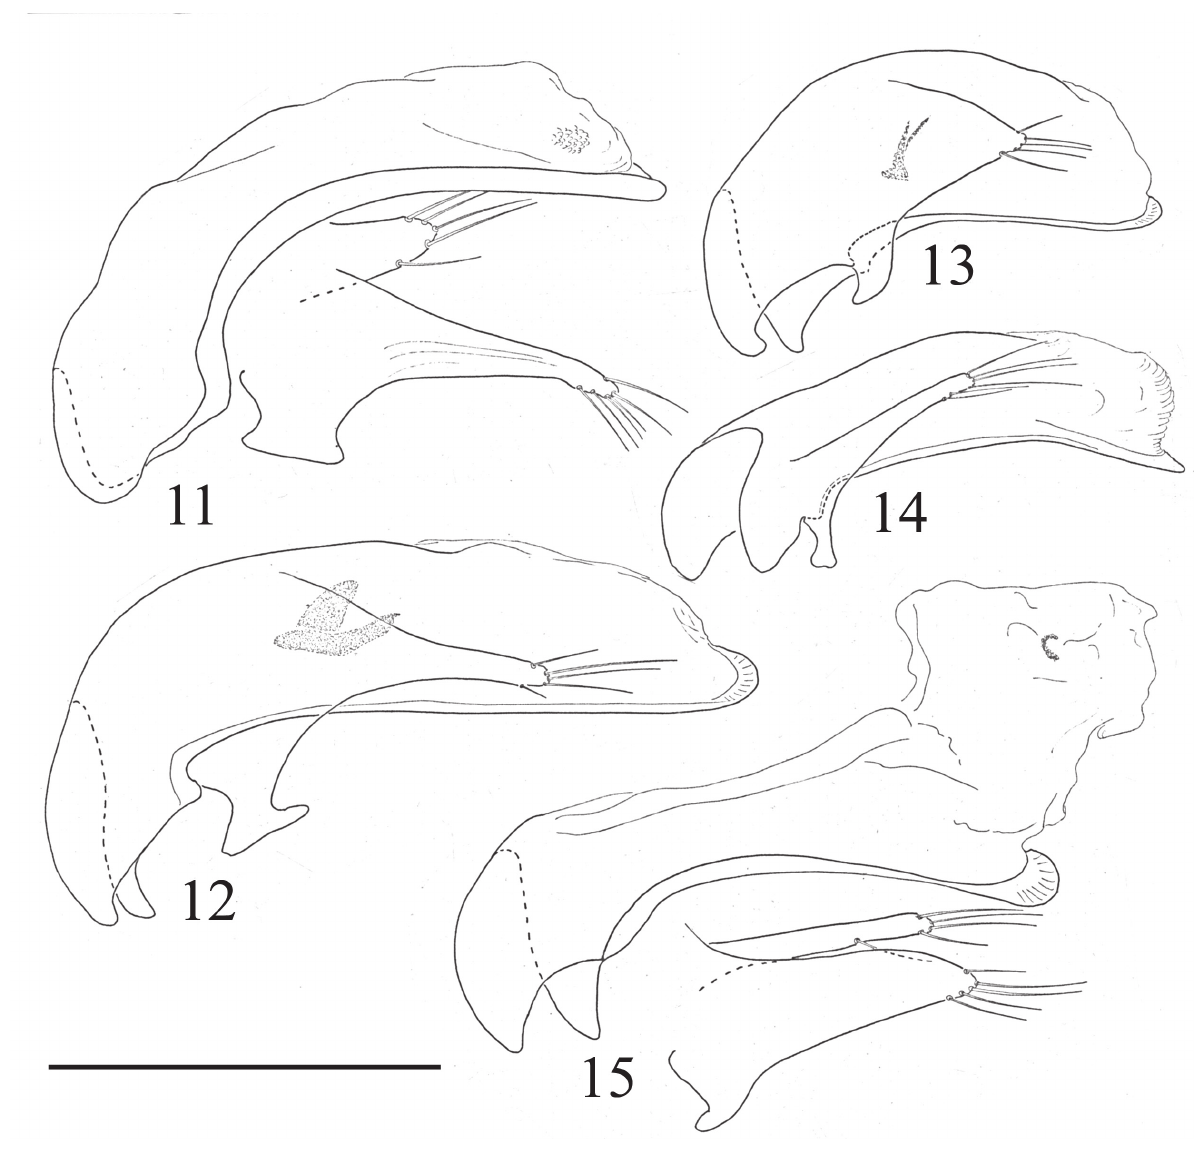
Figs 11-15. Aedeagus in lateral view of Pterocyrtus spp.: 11) P. globosus Sloane, LT ♂ from Cradle Mtn.; 12) P. rubescens Sloane, HT ♂ from Waratah; 13) P. striatulus Sloane, LT ♂ from Cradle Mtn.; 14) P. tasmanicus (Castelnau), ♂ from Tasmania; 15) P. me- ridionalis sp. nov., HT ♂ from Lake Osborne. Scale: 0.5